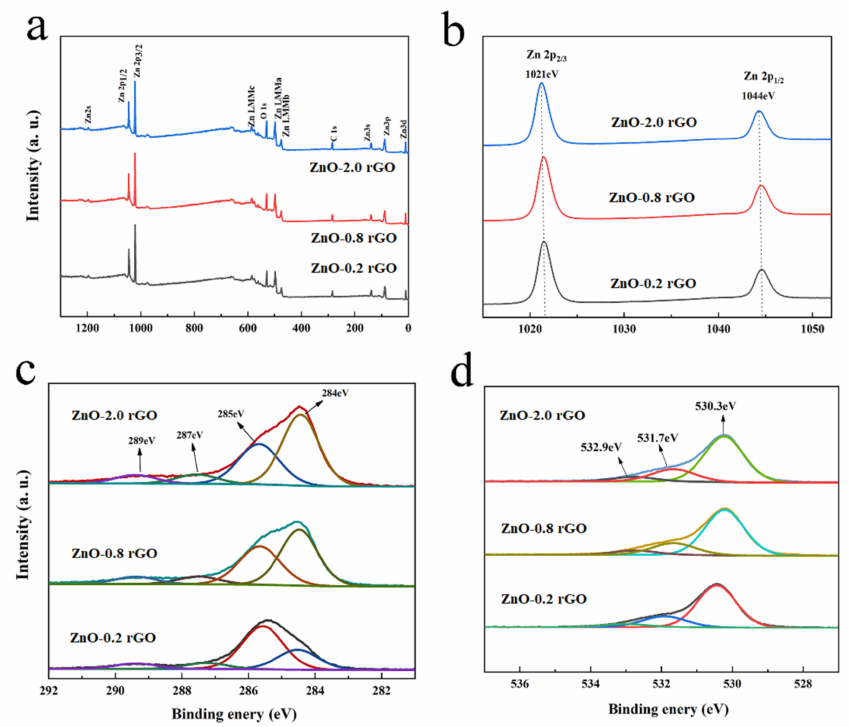
Figure 3. XPS spectra of ZnO-x rGO (x = 0.2, 0.8, 2.0): ( a ) survey scan spectrum; ( b ) Zn 2p spectrum;